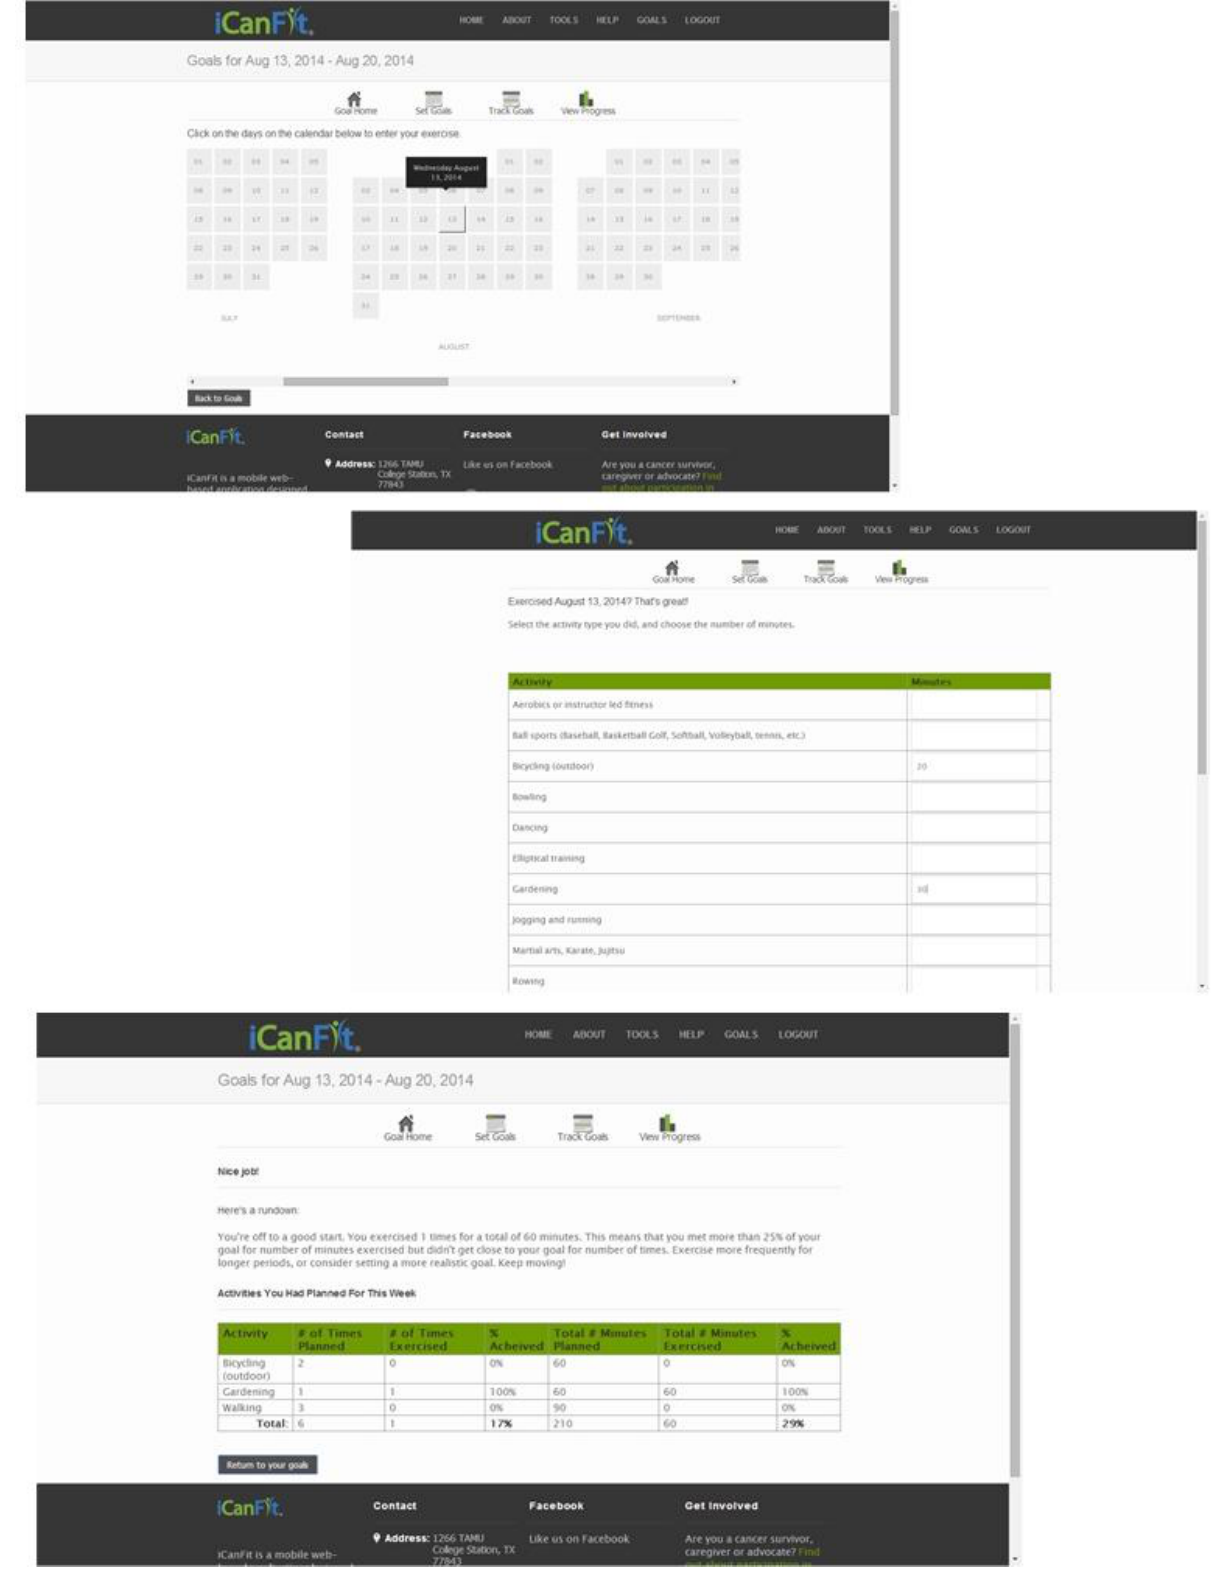
Figure 3. Activity log of